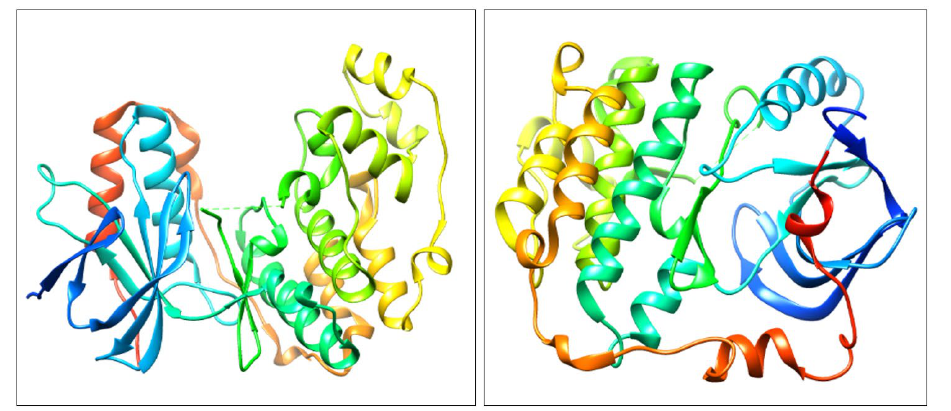
Fig. 1. 3D structure of P38α MAP kinase (4FA2) and EGFR Kinase domain